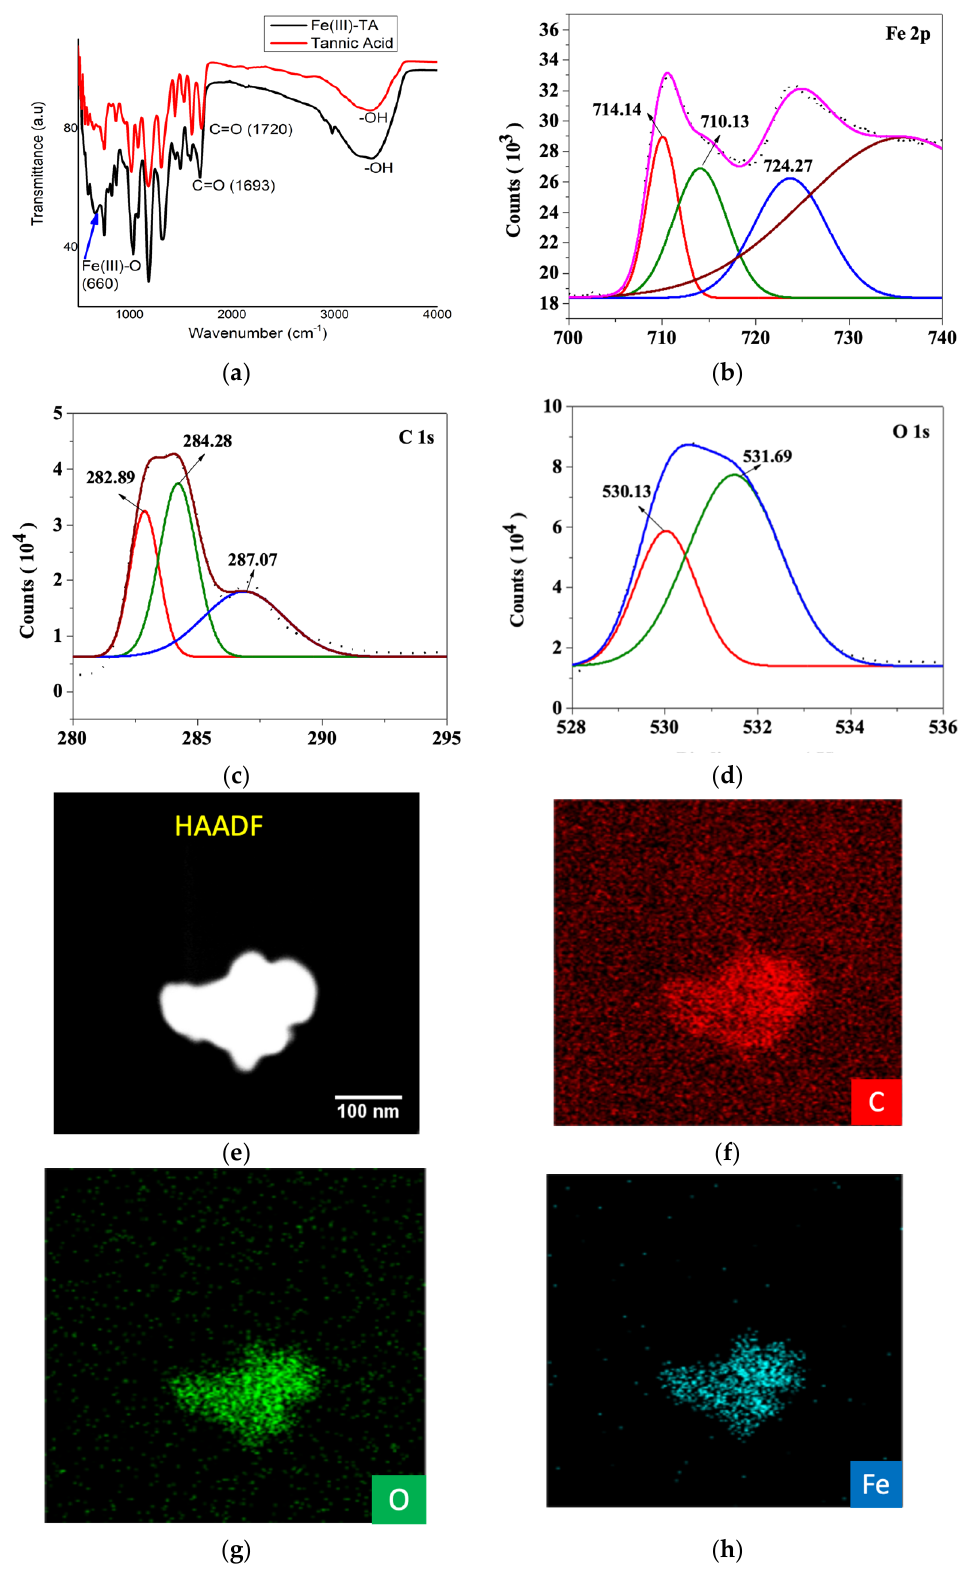
Figure 2. ( a ) FT-IR spectrum; Binding energy spectra of: ( b ) Fe 2p; ( c ) C 1s; ( d ) O 1s. STEM/EDS analysis images of: ( e ) HAADF-STEM and ( f – h ) elemental mapping for C, O, and Fe, respectively, for Fe(III)-TA.